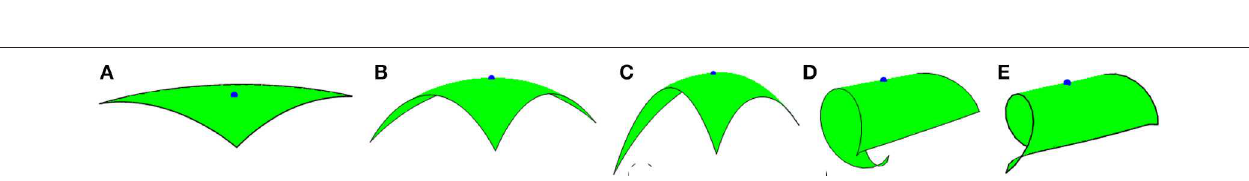
FIGURE 11 | Folding of equilateral triangle plate. (A) Electric field 9 MV/m; (B) electric field 15 MV/m; (C) electric field 20 MV/m; (D) electric field 68 MV/m; and (E) electric field 86 MV/m.